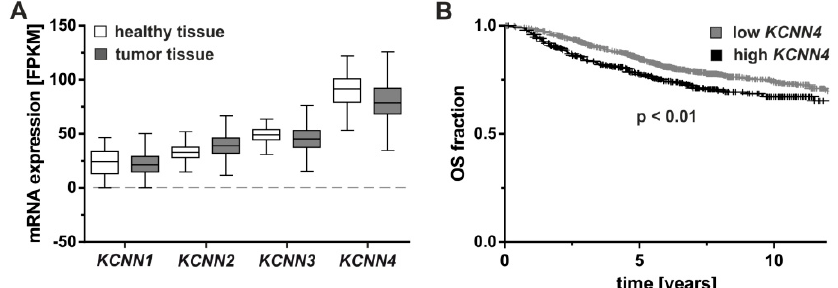
Figure 1. KCNN4 mRNA expression levels in breast cancer and their association with patient survival. ( A ) mRNA expression levels of KCNN1-4 coding for SK1-SK3 and K Ca 3.1 were compared between healthy and breast tumor tissues, measured by RNA sequencing as fragments per kilobase of transcript per million mapped reads (FPKM). Data obtained from The Cancer Genome Atlas [30] revealed no significant difference in a Kruskal–Wallis test with Dunn’s test for multiple comparisons ( α = 0.05 for n = 113 healthy and n = 1095 breast tumor tissues). ( B ) In the Kaplan–Meier plotter [31], significantly prolonged overall survival (OS) was associated with low KCNN4 mRNA levels. Groups were statistically compared by log-rank test (hazard ratio = 1.37 (confidence interval 1.08–1.72) for n = 1030 low and n = 372 high KCNN4 -expressing tumors).